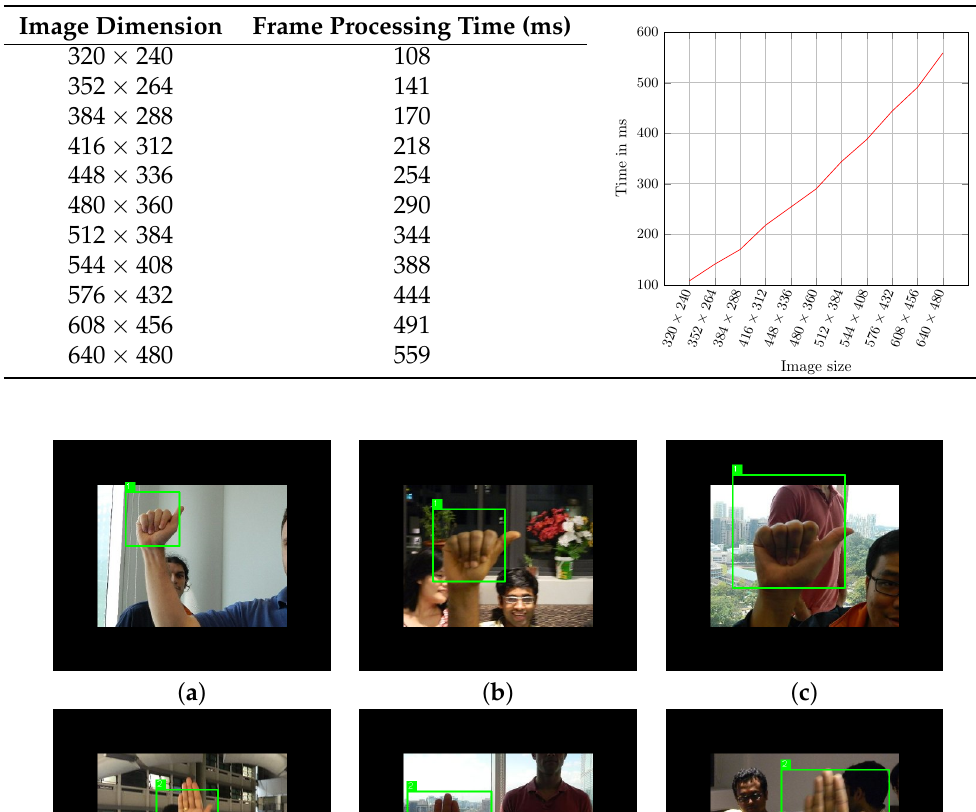
Table 2. Time performance of the system. The multi-posture detector uses 1550 stumps.